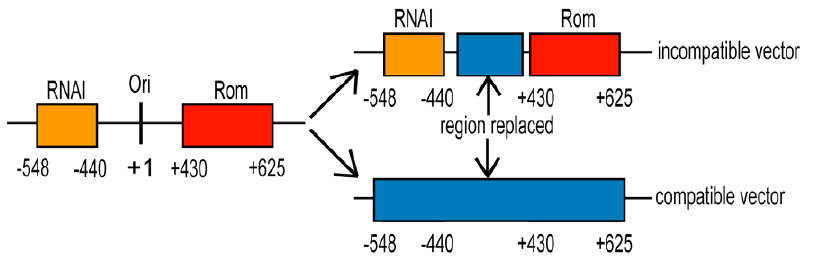
Figure 1. Schematic representation of the replacement of the origin of replication of pBR322 derived vectors. The relative position of RNAI, Rom, and the ori are depicted. When RNAI is retained in the nascent vector, vector incompatibility results upon co-transformation with pBR322- derived vectors. Removal of both RNAI and Rom yields a truly compatible vector.